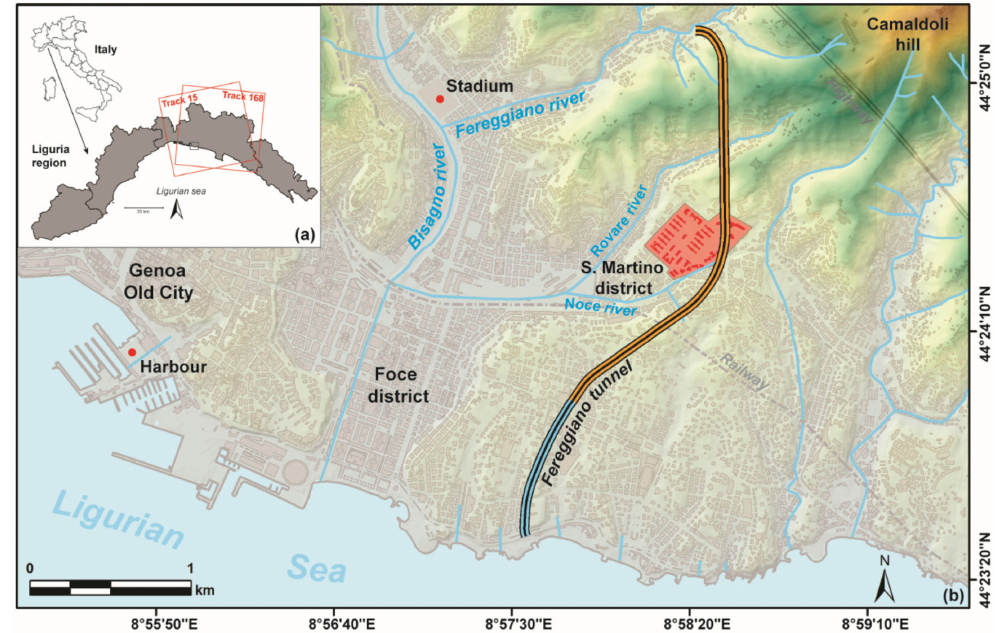
Figure 1. ( a ) Location of the Genoa city. The Ascending (Track 15) and Descending (Track 168) Sentinel-1 frames are outlined in red. The black box indicates the location of the study area. ( b ) Geographical setting of the study